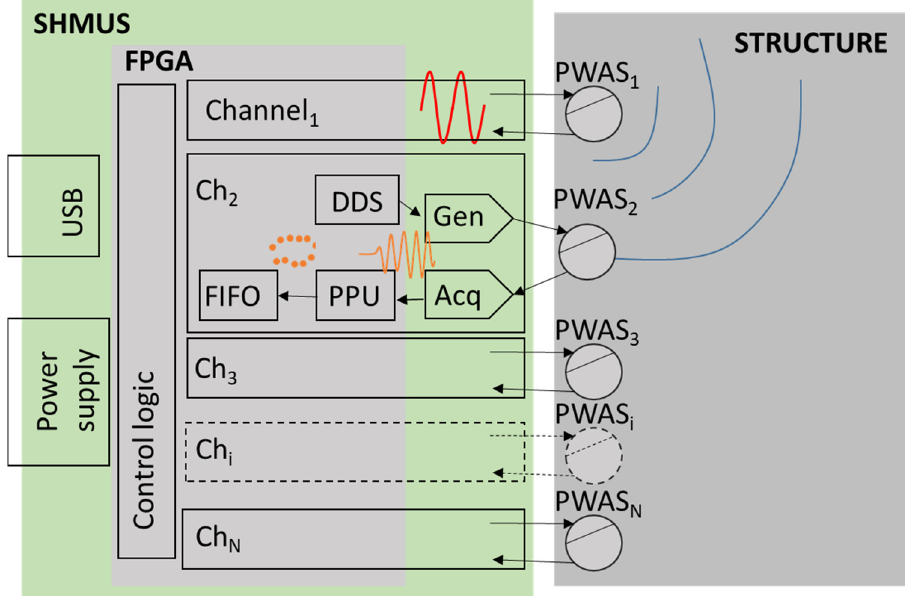
Figure 1. Block diagram of the self-developed SHMUS included in the tests (in red, situation for E1R2, i.e., emission with PWAS 1 and reception with PWAS 2 ).